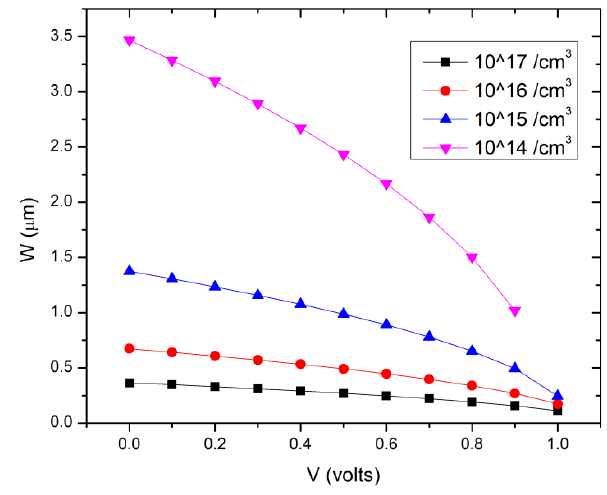
Figure 2. The dependence of W on V at various doping densities.